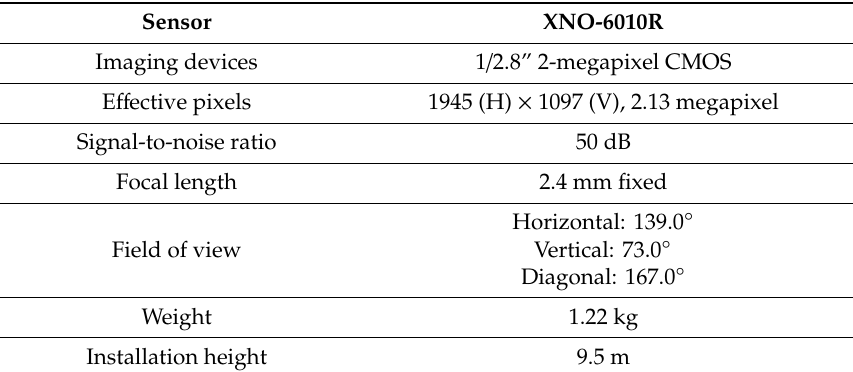
Table 1. Description of